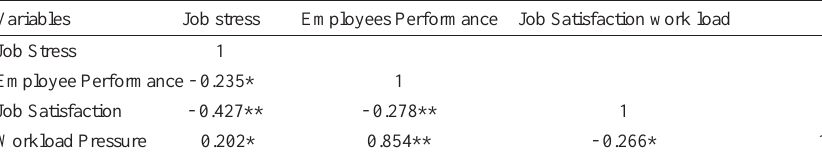
Pearson's Correlation of job stress, employee performance, job satisfaction and workload